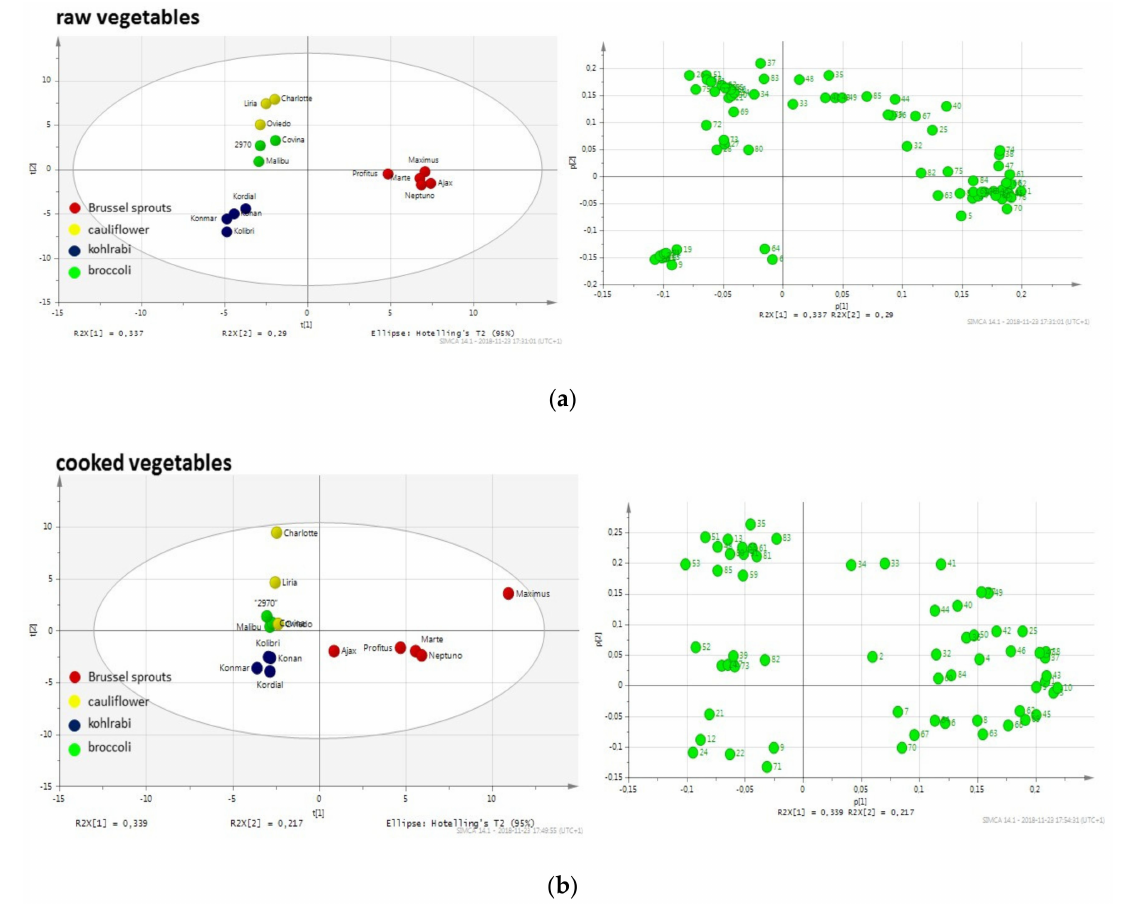
Figure 1. Principal component analysis (PCA) graphs of volatiles extracted from the raw ( a ) and cooked ( b ) Brassica vegetables investigated. Numbers on loadings plot represent compounds characteristic for analyzed vegetables. Compound numbering is uniform with data provided in the Supplementary Table